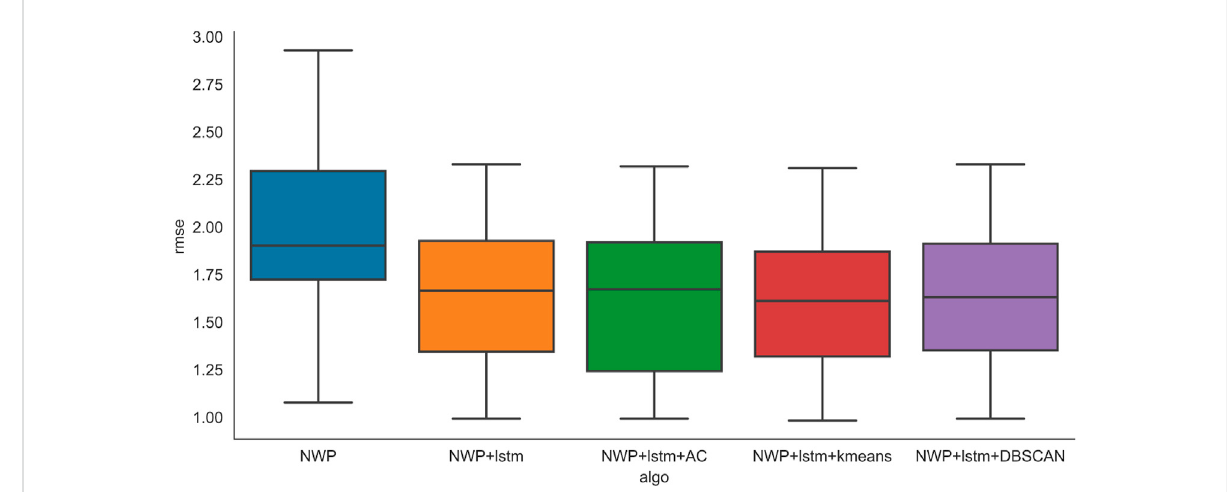
FIGURE 12 Overall rmse results for different clustering methods based on the location.